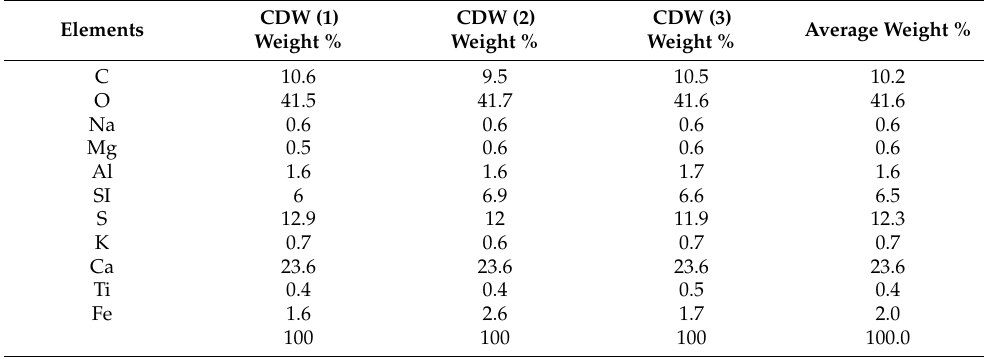
Figure 2. Scanning electron microscope images of industrial materials used in this study: ( a ) ash from bark furnace; ( b ) green liquor slag; ( c ) flotation sand; ( d ) CDW. Table 1. Compositions of the construction waste.